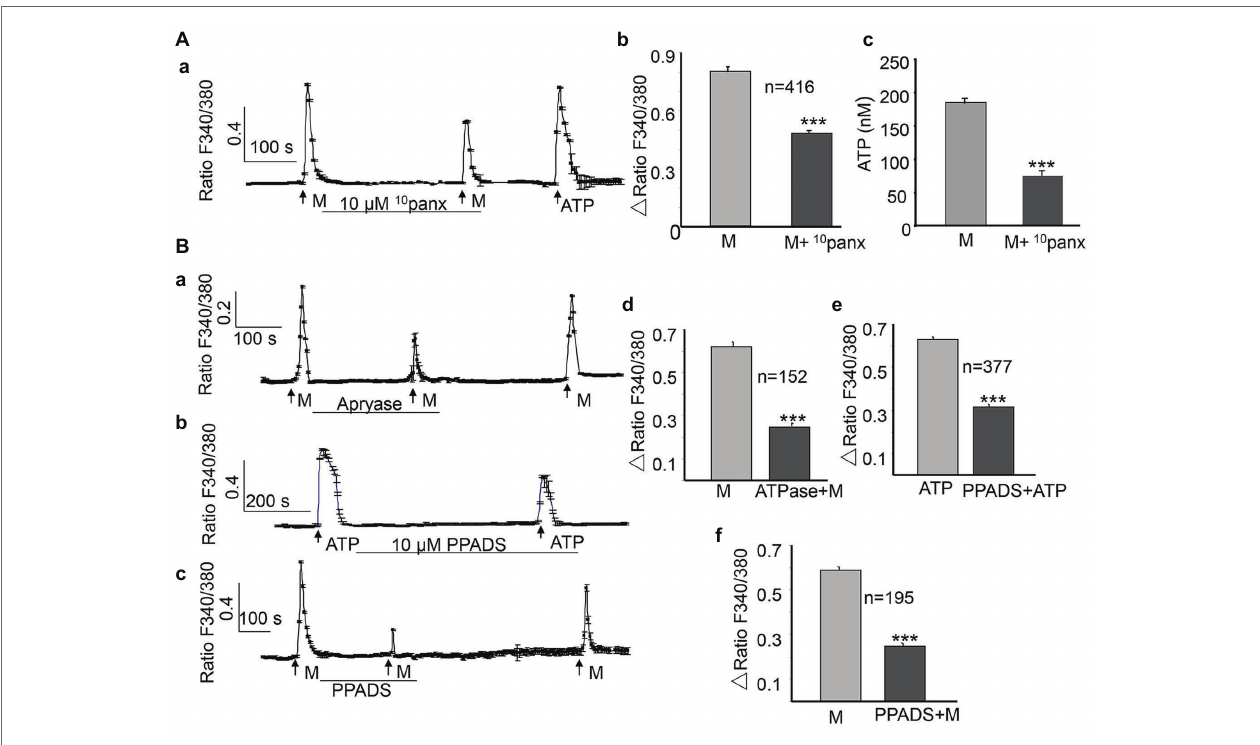
FIGURE 5 | Activation of pannexin 1 channels and ATP release contribute to the ALI-induced [Ca 2+ ] i increase. (Aa–Ac) Typical trace (Aa) and summary data ( Ab , n = 416 cells, p < 0.001) showing that the application of 10 panx (10 μ M), the pannexin 1 channel-specific antagonist, reduced the ALI-induced [Ca 2+ ] i increase and ALI-induced ATP release (Ac) . (Ba–Bc) Typical traces showing that the application of apyrase (10 U/ml) to hydrolyze extracellular ATP reduced ALI-evoked [Ca 2+ ] i increase (Ba) ; and the application of PPADS (10 μ M), the common P2 receptor antagonist, reduced ATP evoked (Bb) , as well as the ALI-evoked [Ca 2+ ] i increase (Bc) . (Bd–Bf) Summary data for apyrase effect ( Bd , n = 152 cells, p < 0.001); PPADS effect on ATP evoked [Ca 2+ ] i increase ( Be , n = 377 cells, p < 0.001); and on the ALI-evoked [Ca 2+ ] i increase ( Bf , n = 195 cells, p <